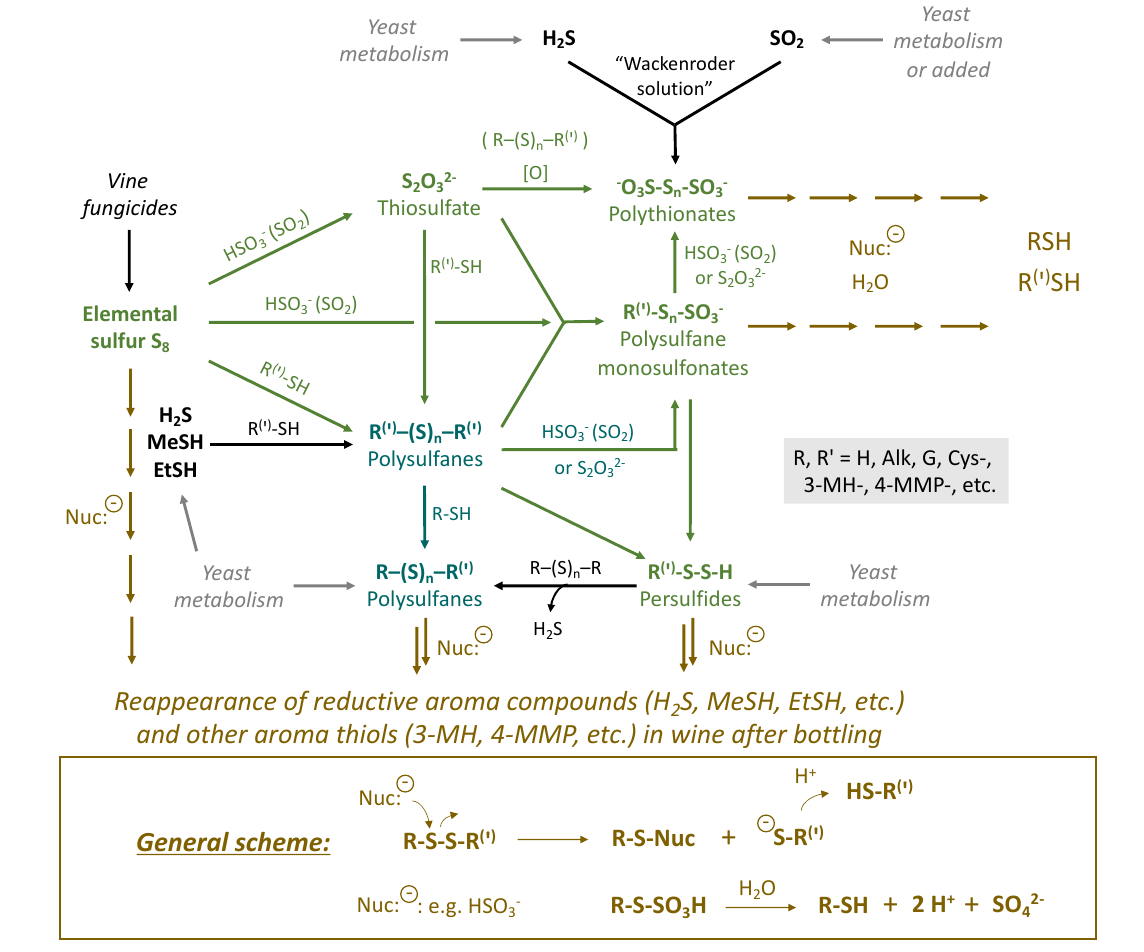
Figure 2. General scheme of the interrelation of sulfane sulfur compounds in wine.